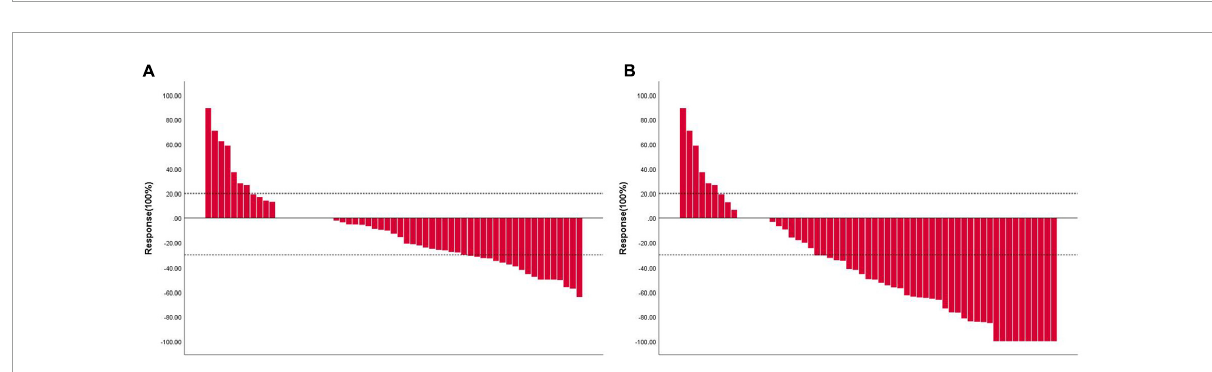
FIGURE2 Waterfall plot showing maximum changes in tumor size of patients receiving HAIC combined lenvatinib and PD-1 antibody. (A) Assessed with RECIST 1.1 in patients with image measurements before and after treatment; (B) assessed with mRECIST in patients with image measurements before and after treatment. RECIST, Response Evaluation Criteria in Solid Tumors; mRECIST, modified Response Evaluation Criteria in Solid Tumors; HAIC, hepatic arterial infusion chemotherapy; PD-1, programmed cell death